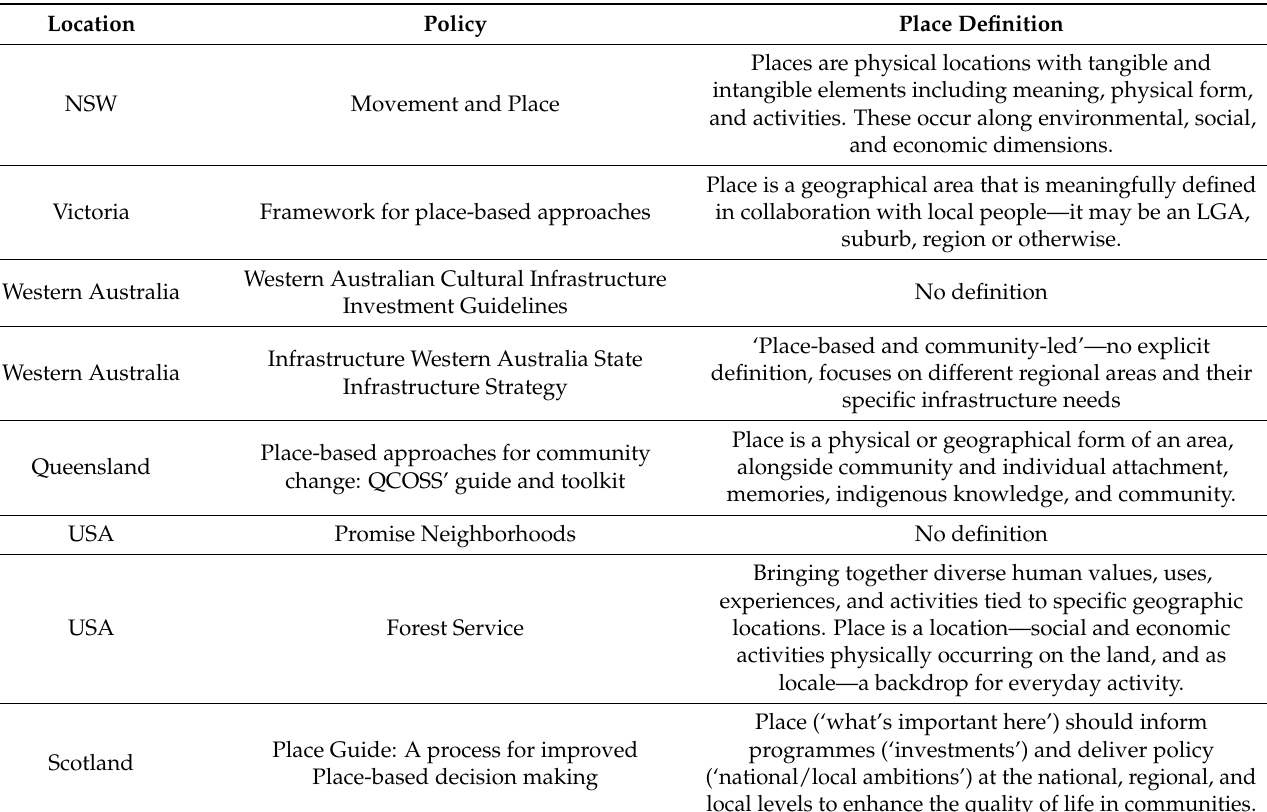
Table 1. Understanding of ‘place’ in place-based